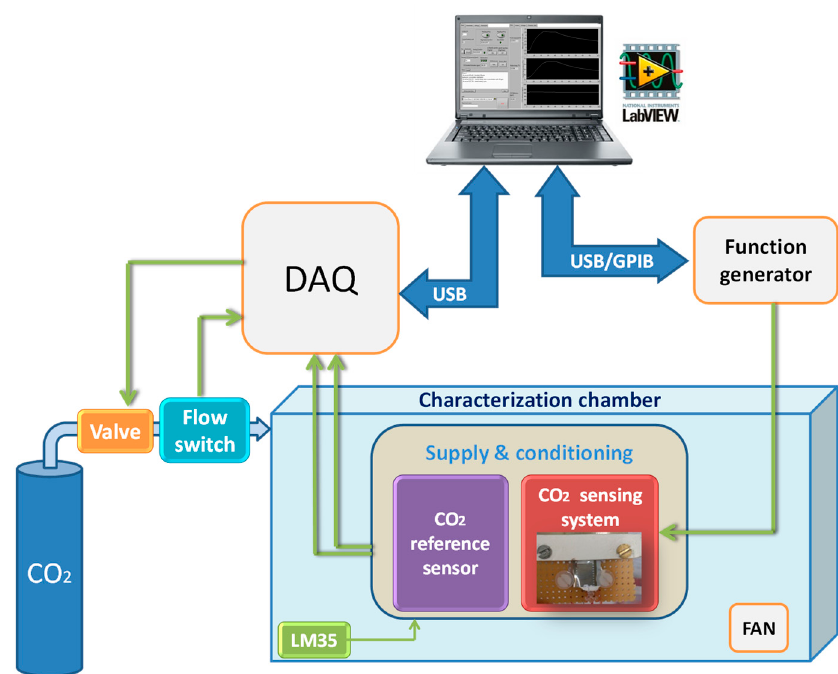
Figure 2. The tool used to assess performances of the sensor developed. The system is composed by an insulated chamber, a reference CO 2 sensor and a gas injection system. Sensors data and flow control are managed by a dedicated LabVIEW instrument.